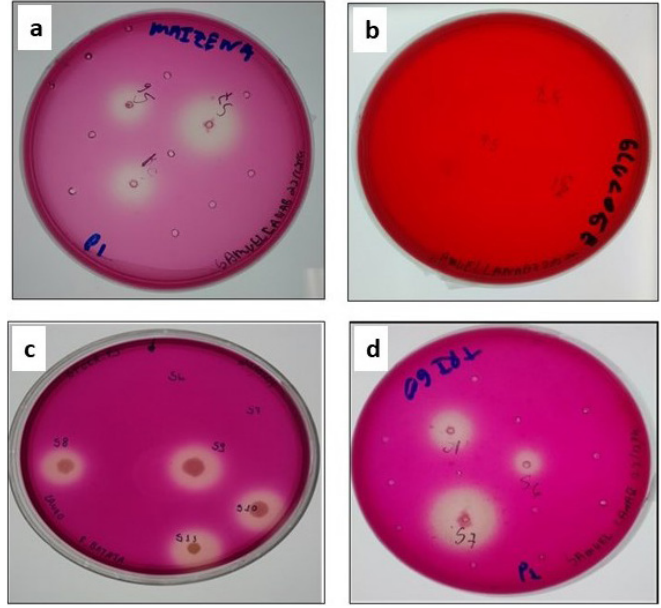
Figure 2 - Petri dishes after 24 hours showing degradation halos in the culture medium containing different starch as carbon source. ( a ) Cornstarch; ( b ) Glucose; ( c ) Potato; ( d ) Wheat.